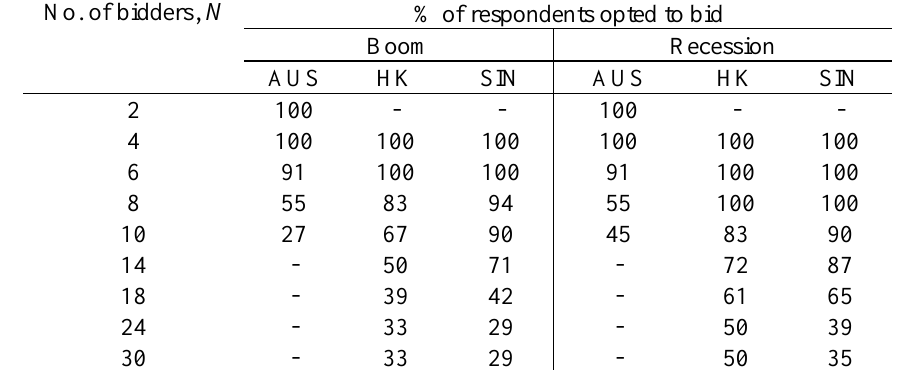
Table 1: Respondents opted to bid according to market conditions and number of bidders